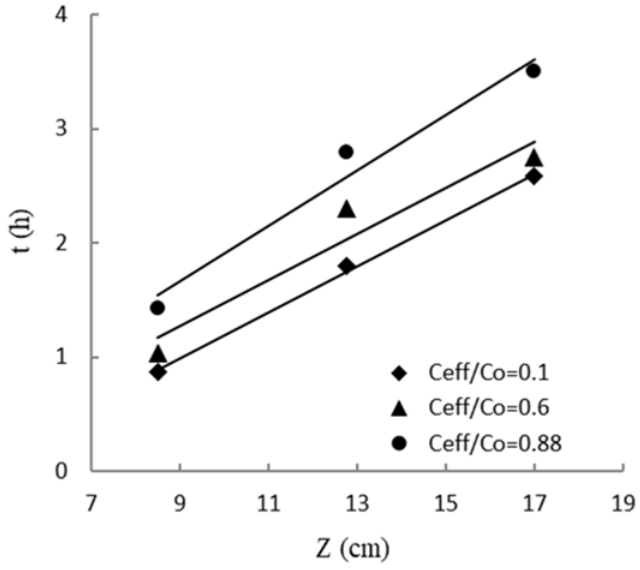
Table 5. Service time model parameters for bed depth used for phenol adsorption ( C 0 given as 1000 mg/L; Q given as 10 mL/min).